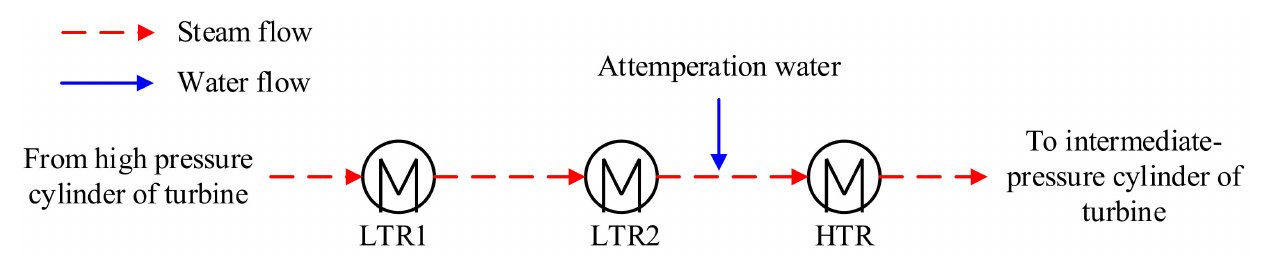
Figure 2. Diagram of the reheated steam